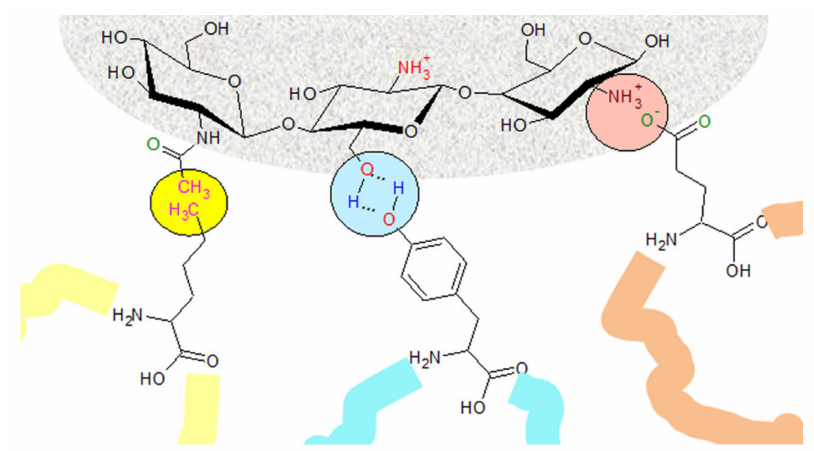
Figure 5. Chemical structure of chitosan on the surface of NPs, and possible interactions with proteins’ amino